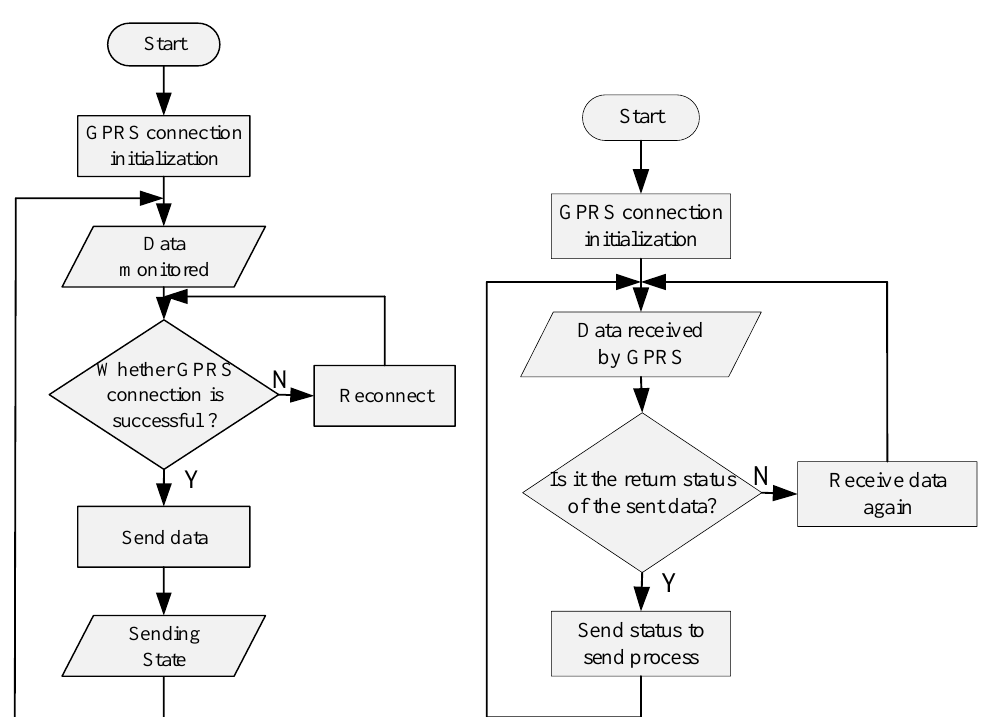
Figure 9. The flow chart of GPRS data sending and receiving software.